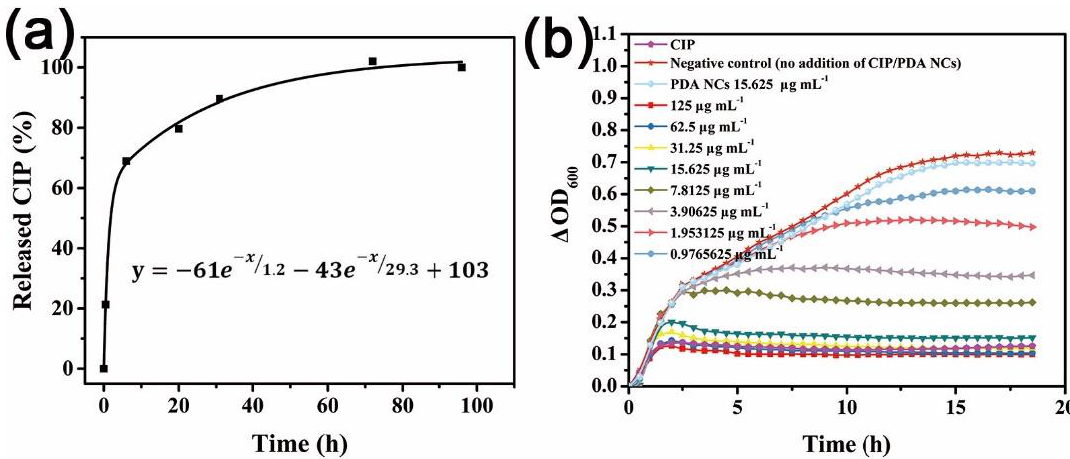
Figure 6. ( a ) CIP-release kinetics from PDA NCs at 37 ◦ C in PBS; ( b ) Growth kinetics of the E. coli bacteria in the presence of CIP-PDA. A positive control (0.2 µ g mL − 1 pure CIP), a negative control (no addition of CIP / PDA NCs), and PDA NCs (15.625 µ g mL − 1 ) without the CIP were tested.